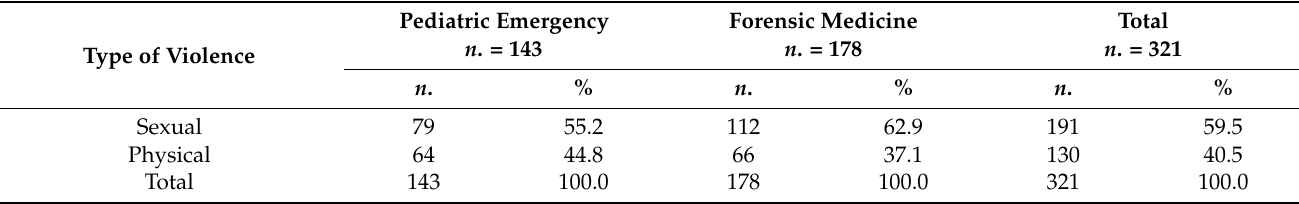
Table 1. Type of violence among the pediatric patients seen at pediatric emergency and forensic medicine at MCH from 1 January to 31 December 2019.